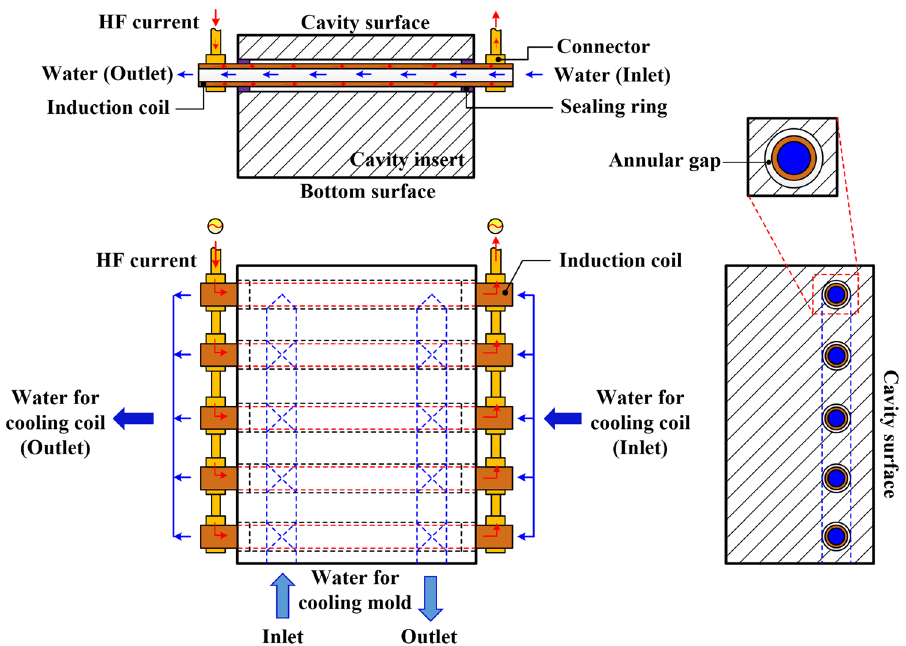
Fig. 1 Schematic of newly developed RTCM with internal induction heating and water